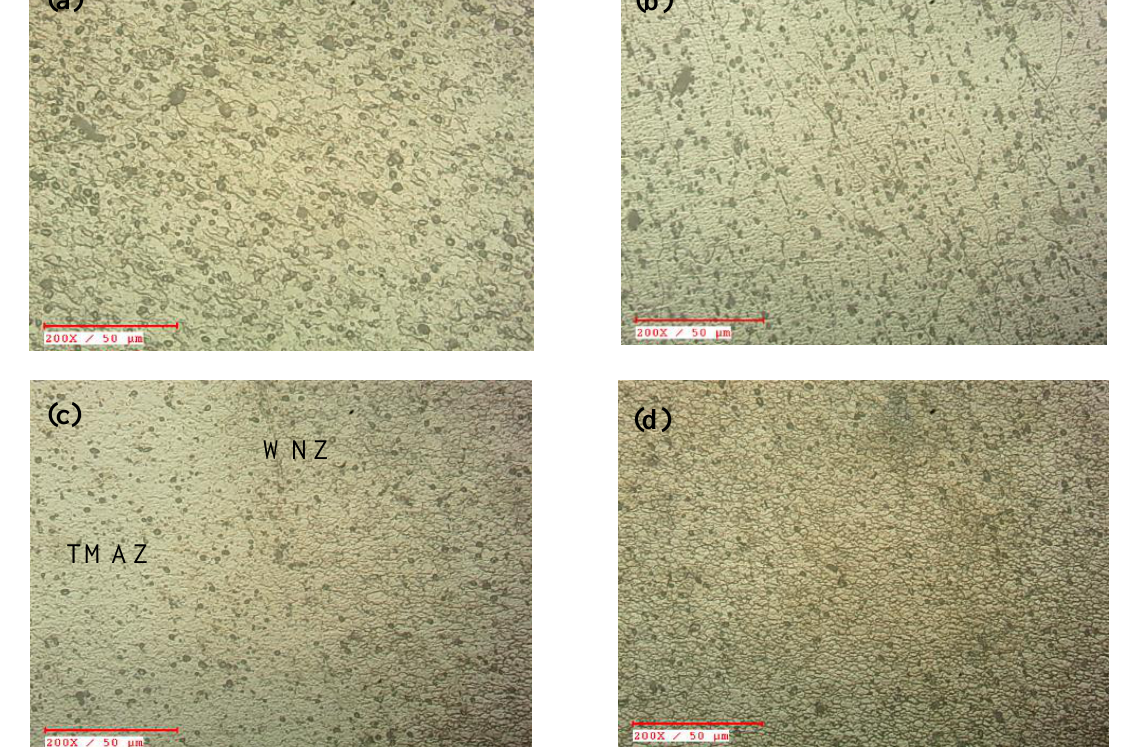
Figure 6. Microstructures observed with an optical microscopy of the typical joint welded with room temperature water jet cooling approach (C-RJ): ( a ) BM ( b ) HAZ ( c ) interface of TMAZ and WNZ ( d ) WNZ